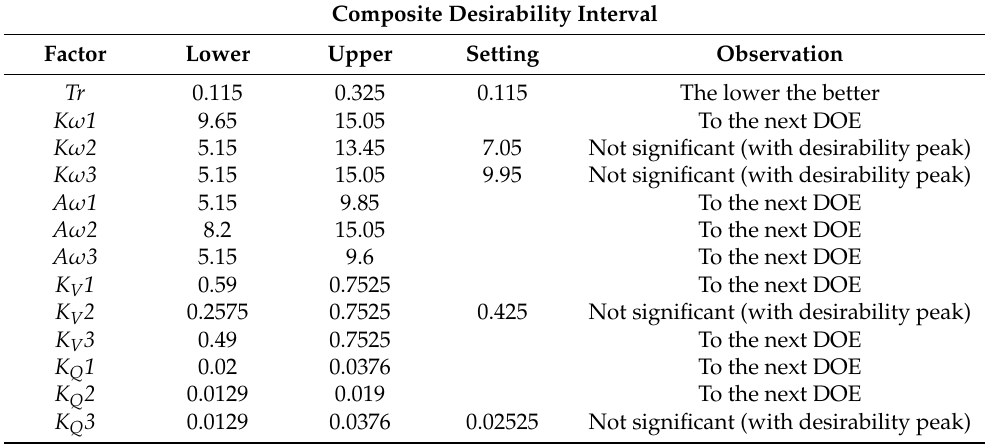
Table 5. Main findings from the screening